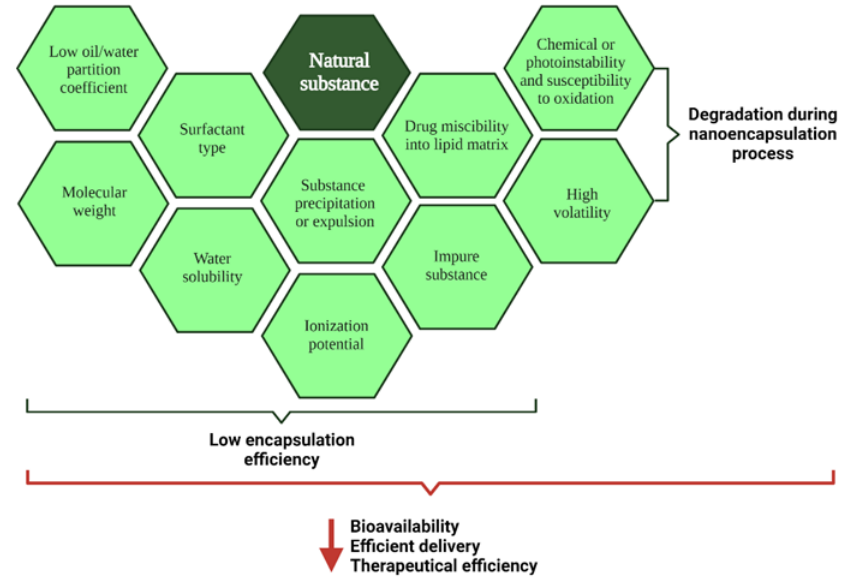
Figure 7. Technical challenges to encapsulate natural substances into